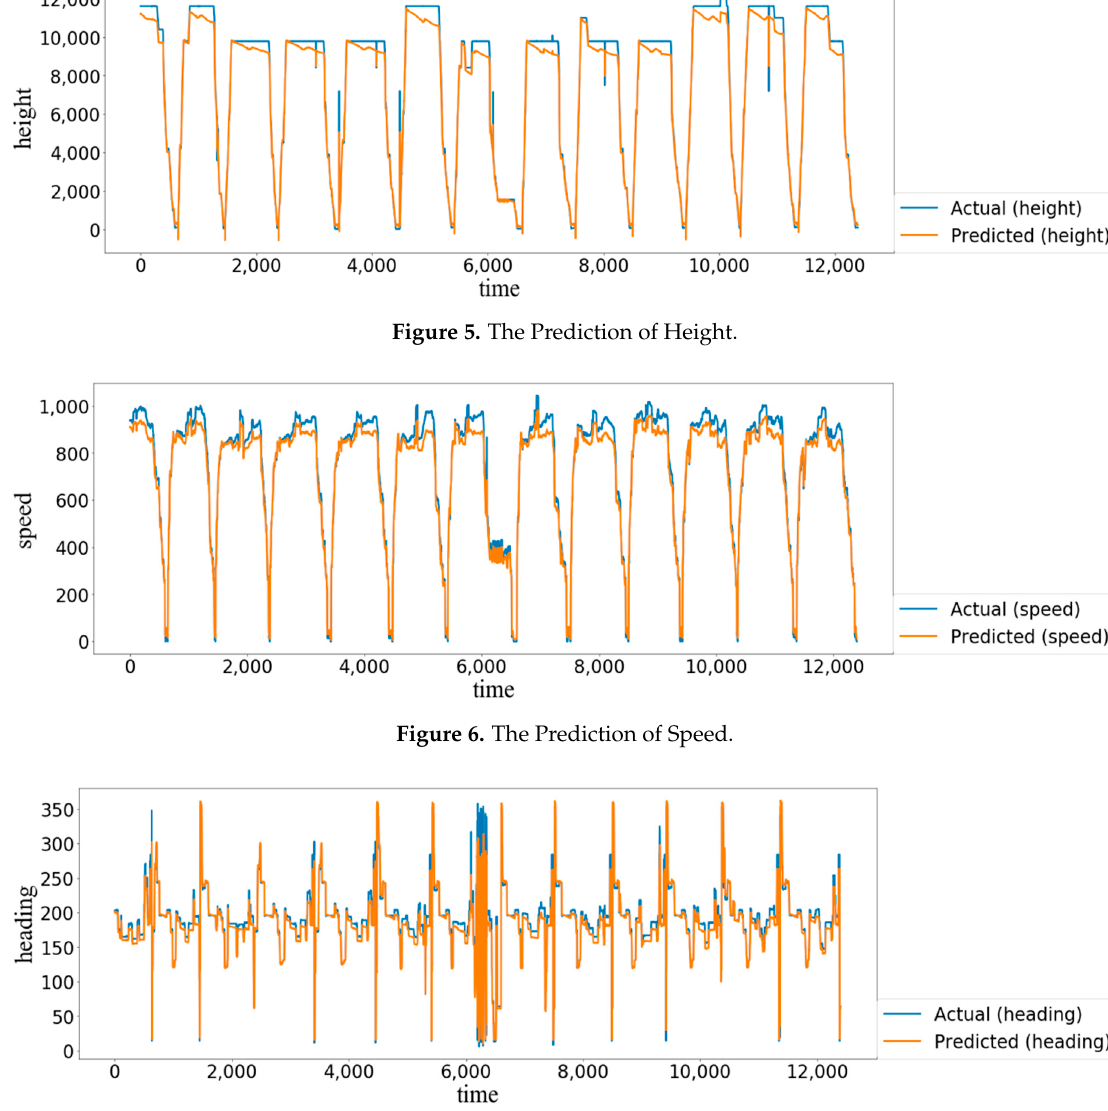
Figure 7. The Prediction of Heading.